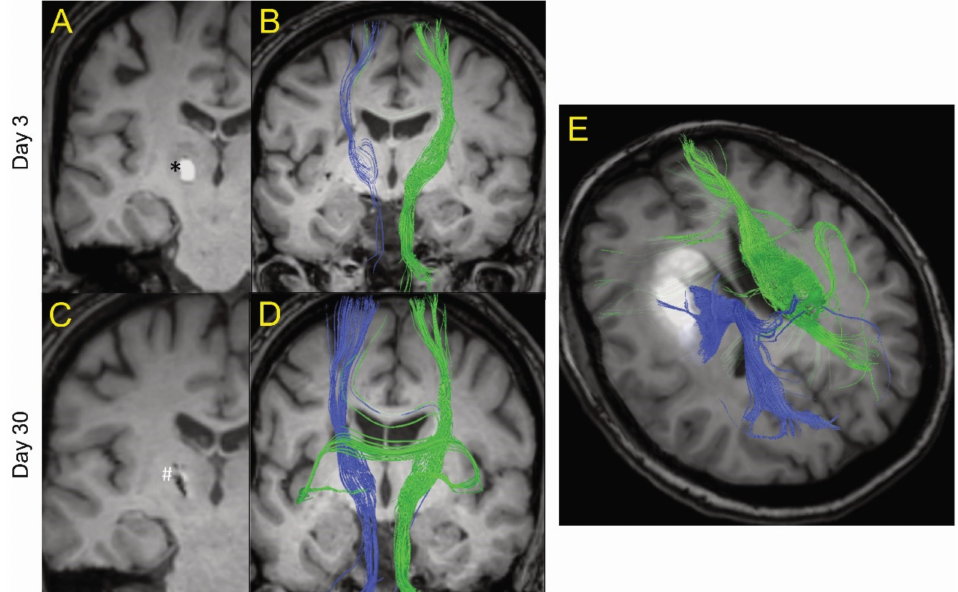
Figure 1. Example of MRI tractography of intracerebral hemorrhage patients. The images are postprocessed 2D axial images with projected WM fibers in 3D in a cranio–caudal direction. One patient (age 50s) is shown at day 3 ( A and B ) and day 30 ( C and D ) after ictus. Blue fibers are ipsilateral and green fibers are contralateral to the hematoma. At day 3, there was a general decrease in the fiber tracts (blue) ipsilateral to the hematoma (shown as * in A ) compared to contralateral tracts (green). However, there was evidence of some white matter fibers crossing the hematoma. At day 30, the hematoma has largely resolved (shown as # in C ) and there was a recovery of the ipsilateral fiber tracts. ( E ) MRI tractography of a patient (age 60s) with a larger hematoma (19.4 mL) at day 14. It too showed evidence of white matter tracts crossing the